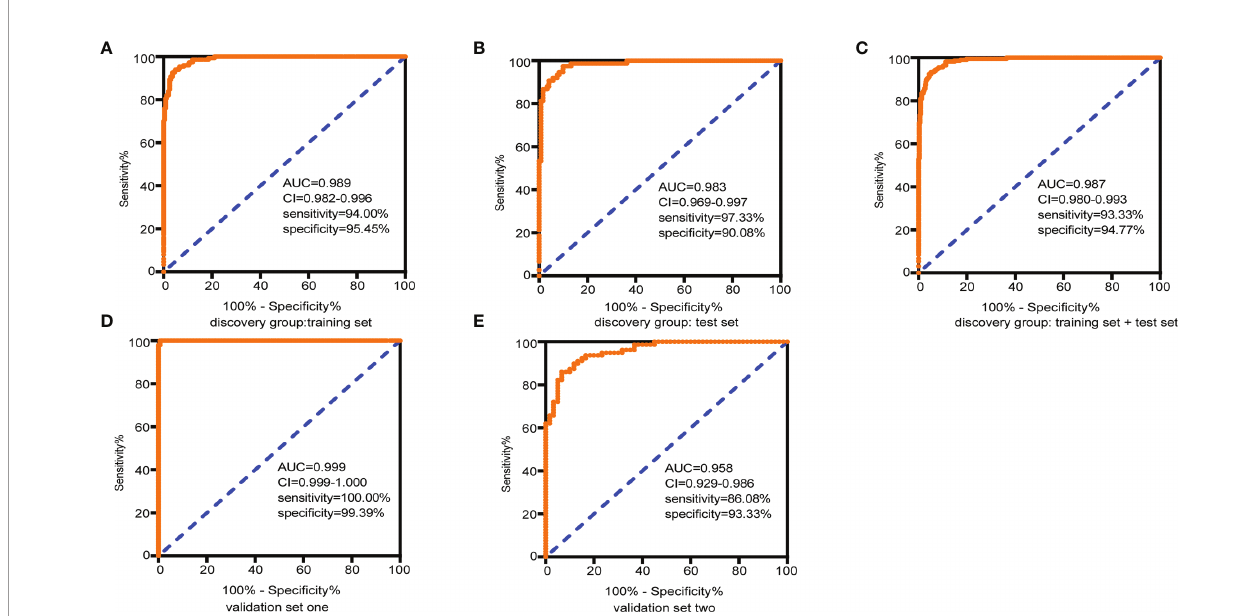
FIGURE 3 | Diagnostic capacity of the combined 15 selected metabolite biomarkers in discrimination of ESCC and controls assessed by receiving operator characteristic (ROC) curves. (A) Training set, 150 tumors and 242 normal samples; (B) test set, 75 tumors and 121 normal samples; (C) the discovery group (training set + test set), 225 tumors and 363 normal samples; (D) validation group 1, 146 tumors and 165 normal samples; and (E) validation group 2, 79 tumors and 60 normal samples. Abbreviations: AUC, area under the curve in the ROC curves; 95% CI, 95% con fi dence interval. See also Table S7 .